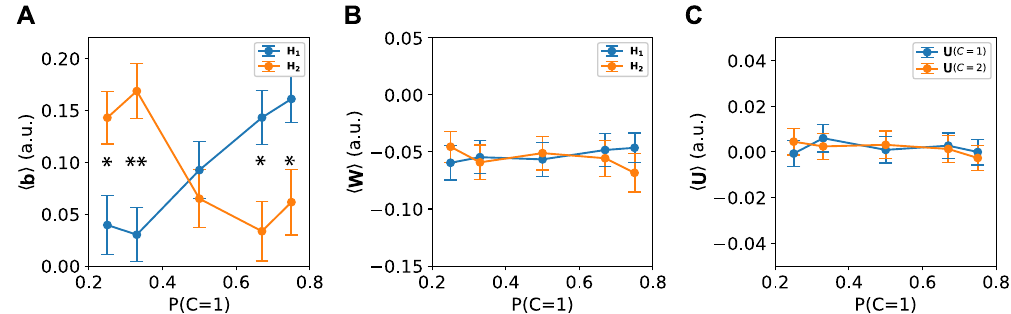
Figure 5. Prior probability encoded by changing activation thresholds. The hidden units could change the decisions of the output units using the bias parameters ( b ), hidden weights ( W ) or output weights ( U ). For every hidden neuron, it was determined whether it contributed stronger to class 1 or class 2 by comparing 1 ) , against the output weights to class 2, U ( C 2 ) . That resulted in two the output weights to class 1, U ( C = = H U ( C H U ( C 1 ) > U ( C 2 ) 1 ) < U ( C 2 ) subpopulations of hidden units: H 1 and H 2 . The = [ = = ] = [ = = ] biases and weights of the hidden units were averaged accordingly and are plotted for different prior probability 1 ) 0.25, 0.33, 0.5, 0.67, 0.75 ratios ( P ( C ). (A) Only the biases of the hidden neurons changed as a result = ∈ [ ] of different prior probabilities, where a higher probability of a class led to higher bias values in neurons coding for this class, thus lowering the activation threshold in these neurons. (B) The hidden weights did not change with prior probability. (C) Neither did the output weights. Error bars represent standard error over the units. (* 0.001 < p < 0.01 , ** p < 0.001